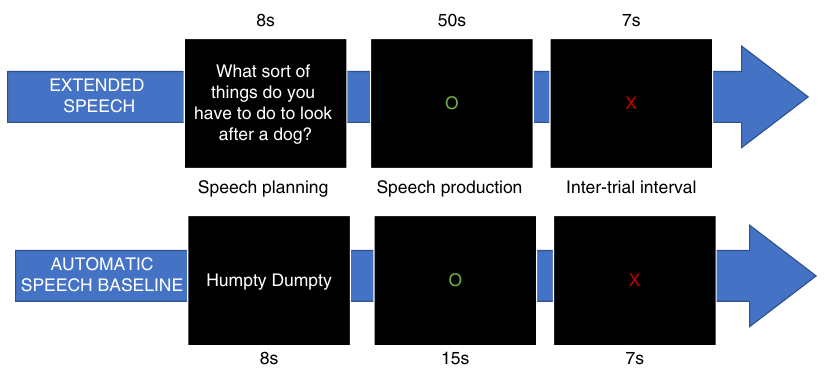
Fig. 6 Illustration of single